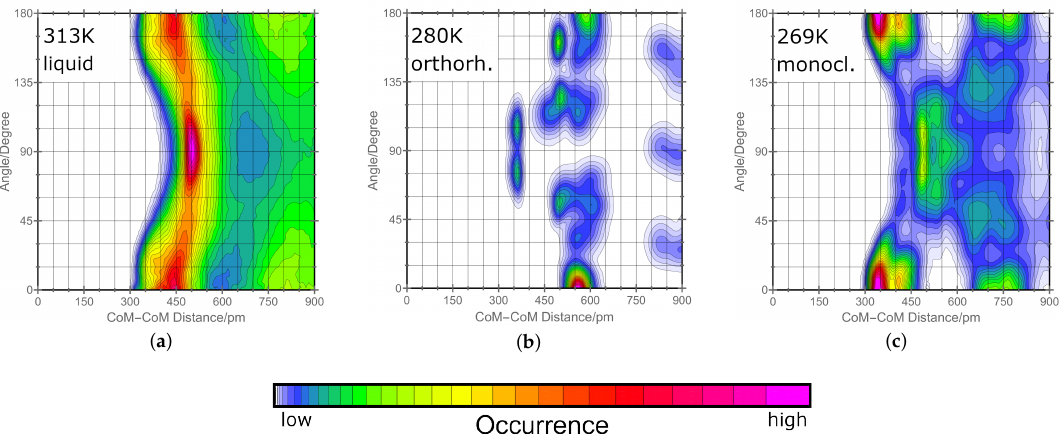
Figure 2. Combined distribution function of the distance between the ring mass centers of two triazole molecules and the angle between this connection line and the normal of the ring plane of the reference triazole molecule as defined in Figure 1. The graph ( a ) shows the orientations in liquid phase at 313K. In the center ( b ), the corresponding graph for the orthorhombic phase at 280K is shown and on the right ( c ), the orientations within the monoclinic phase at 269K is presented. Lowermost, the color scheme for the qualitative probability of occurrence is given which holds for all the graphs above.